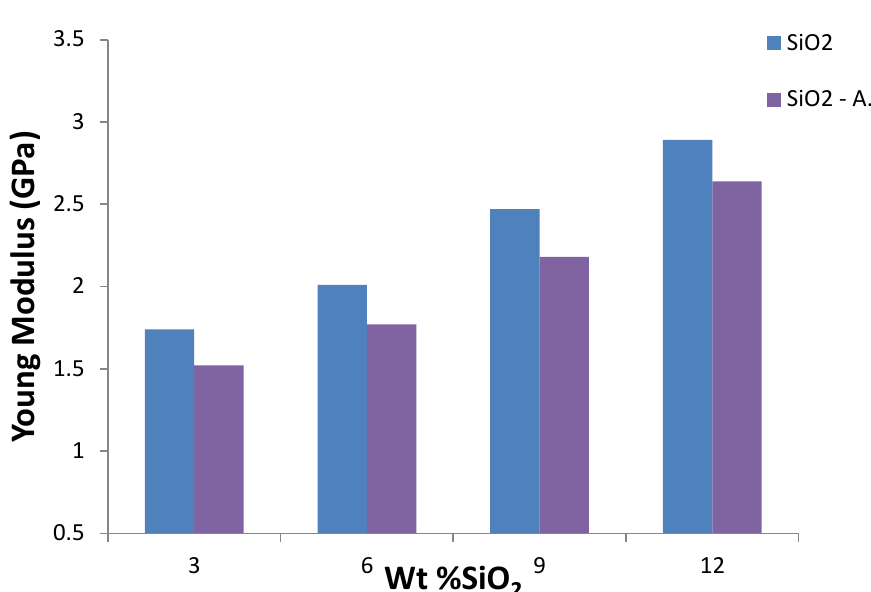
Fig. 7: Comparison of Young's modulus values with different weight fraction of SiO normal conditions and after immersing in diluted sulfuric acid for 10